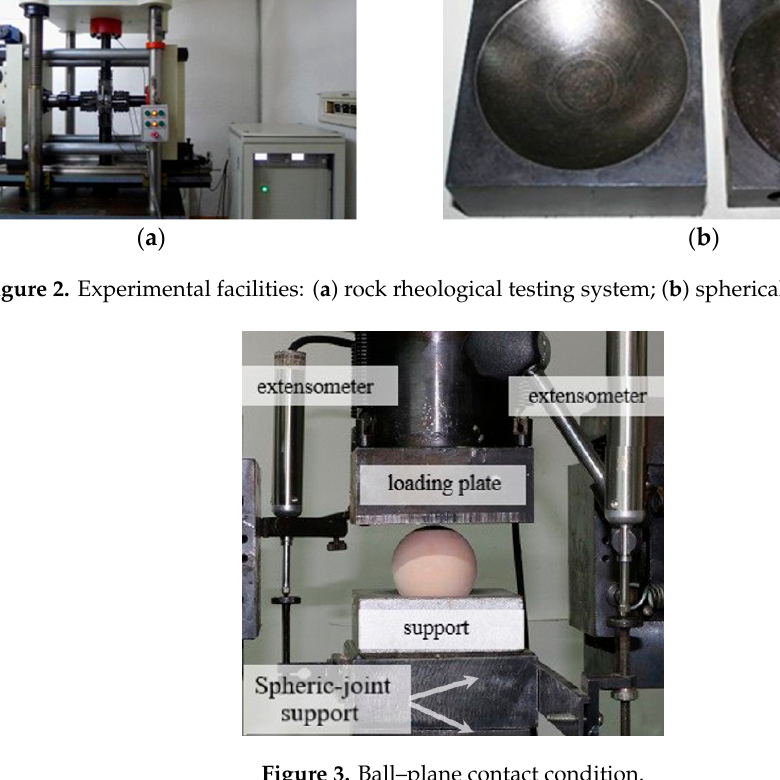
Figure 3. Ball–plane contact condition